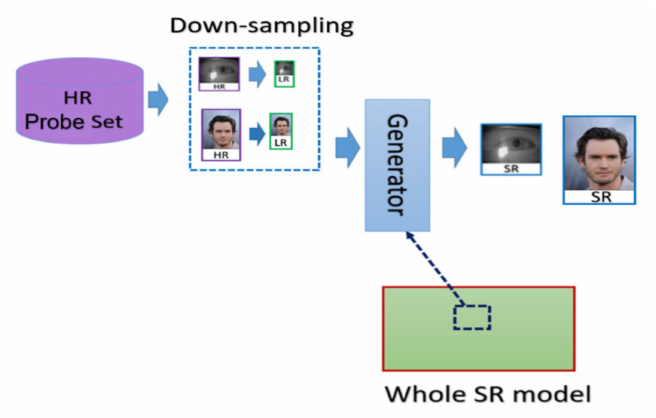
Figure 7. The flow chart of the SR images generation